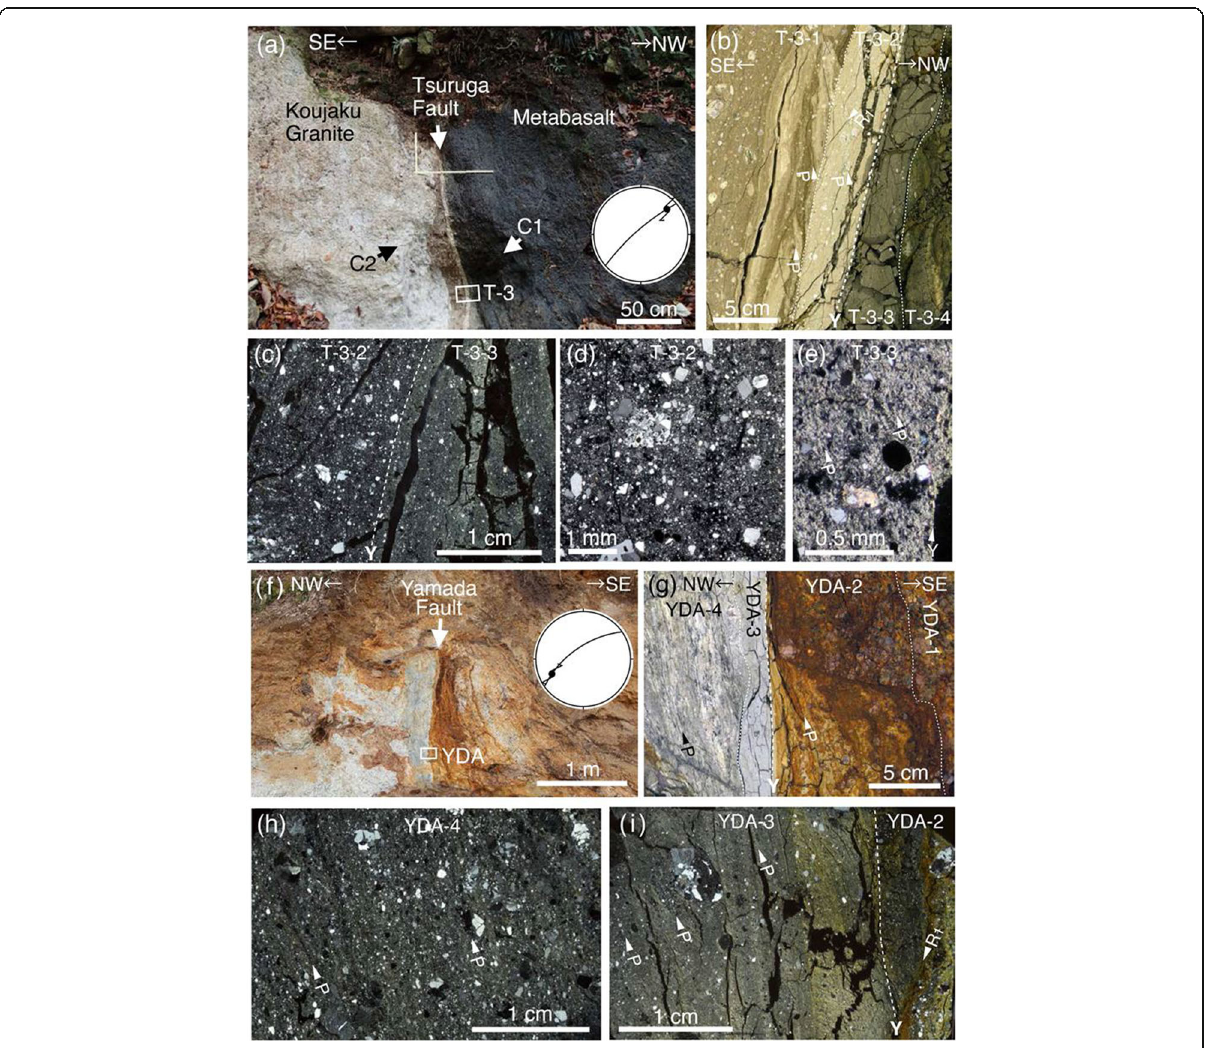
the Tsuruga Fault. b T-3. c T-3-2 – T-3-3. d T-3-2. e T-3-3. f The Mushu outcrop of the Yamada Fault. g YDA. h YDA-4. i YDA-2 – YDA-3. Stereoplots show the orientation of fault plane Y and slip direction in the zone formed during the most recent fault movements ( a , f ). Abbreviations: P : P